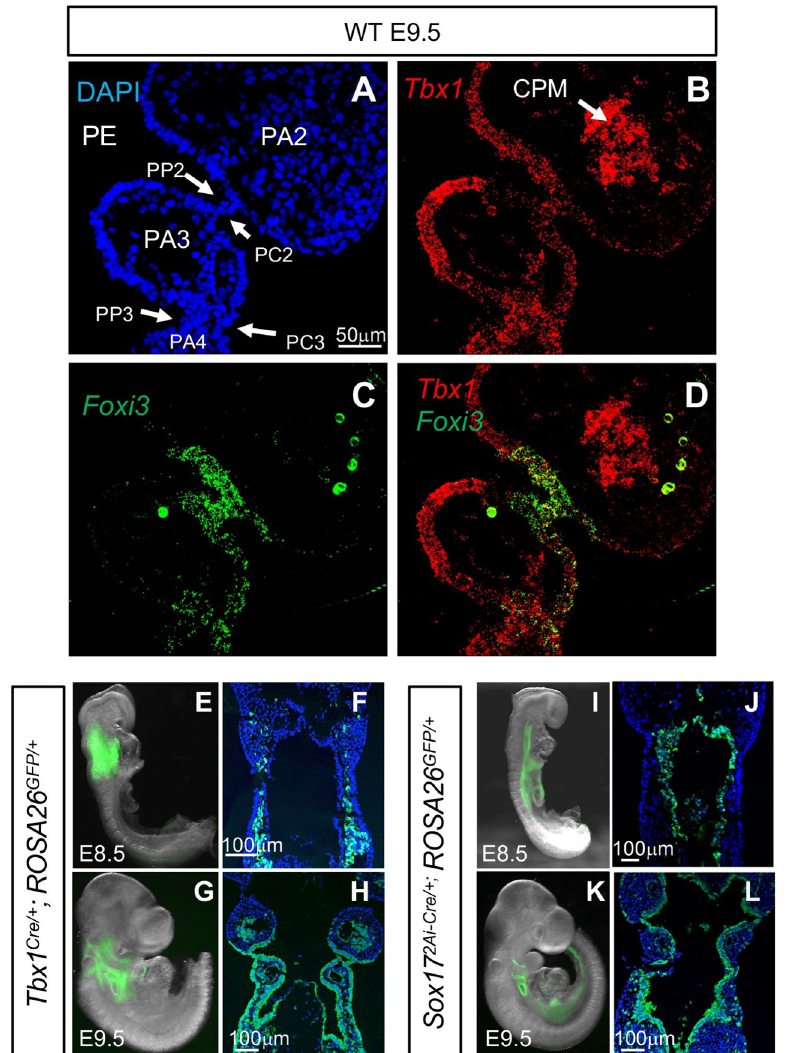
Fig 3. Foxi3 and Tbx1 expression in embryonic pharyngeal pouches and Tbx1 Cre and Sox17 2A-iCre lineages. (A-D) RNAscope in situ hybridization with mRNA probes for Foxi3 and Tbx1 on coronal sections from a WT embryo at E9.5. Tbx1 expression is shown in red and Foxi3 expression is shown in green. Abbreviations: Pharyngeal endoderm (PE); pharyngeal pouch 2 (PP2); pharyngeal cleft 2 (PC2); pharyngeal pouch 3 (PP3); pharyngeal cleft 3 (PC3); and cardiopharyngeal mesoderm (CPM). Total of n = 3 embryos. (E-H) Lineage tracing of Tbx1 Cre/+ ;Rosa26 GFPf/+ embryos. GFP expression is visible in whole mount embryos and the corresponding coronal sections at E8.5 (E-F) and at E9.5 (G-H); n = 3 for each genotype and stage. (I-L) Lineage tracing of Sox17 2A-iCre/+ ; Rosa26 GFPf/+ embryos. GFP expression is visible in whole mount embryos and the corresponding coronal sections at E8.5 (I-J) and E9.5 (K-L); n = 4 for each genotype and